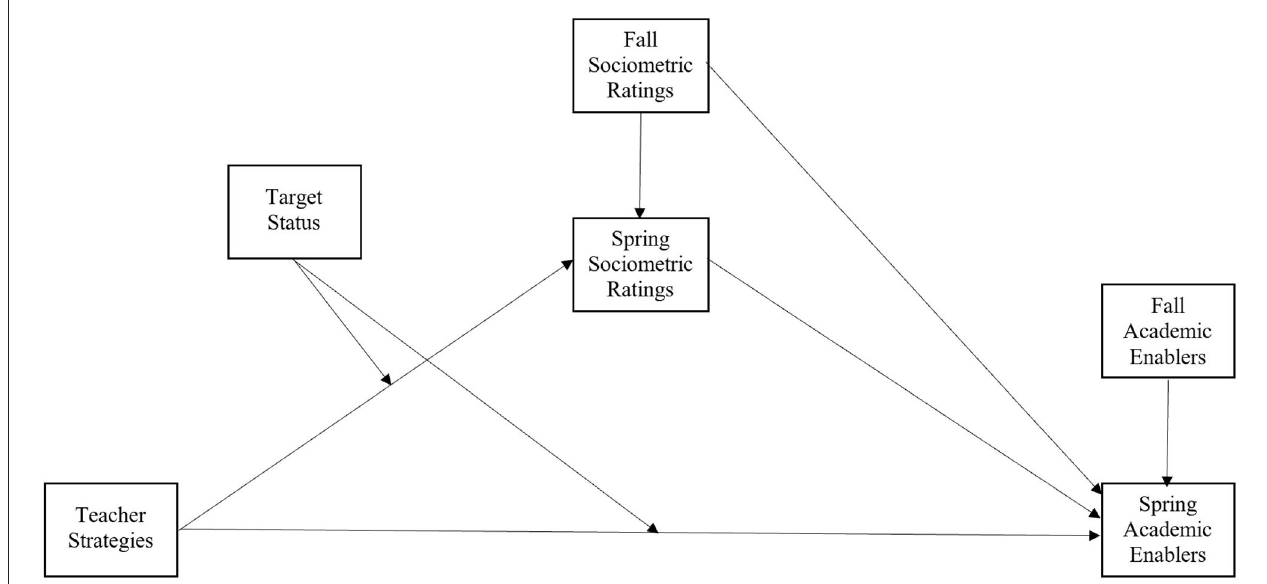
FIGURE 1 | Diagram for the conceptual model. Aim 1: Examines the direct effects of teacher strategies on academic enablers. Aim 2: Examines the indirect effects of spring sociometric ratings on the relationship between teacher strategies and academic enablers. Aim 3: Examines whether the above direct and indirect effects are moderated by target student